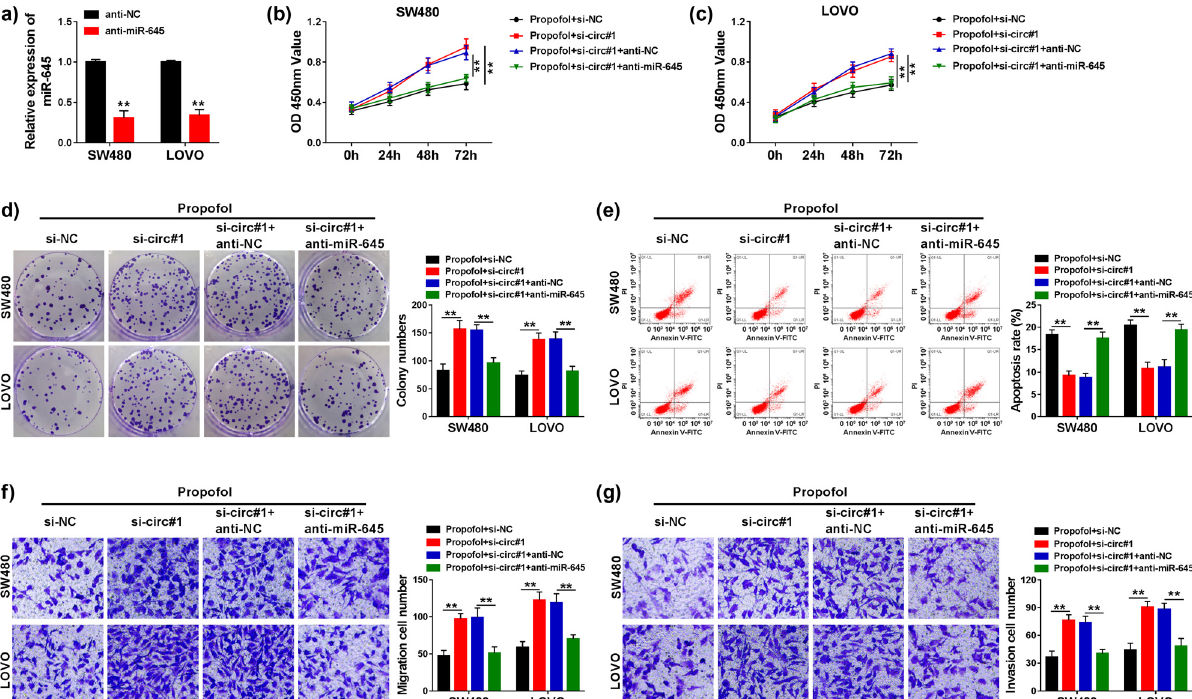
Figure 5: circ_0026344 regulated CRC development by binding to miR - 645 in propofol - treated SW480 and LOVO cells. ( a ) miR - 645 expression was detected by qPCR in SW480 and LOVO cells transfected with anti - NC or anti - miR - 645. SW480 and LOVO cells were treated with propofol + si - NC, propofol + si - circ#1, propofol + si - circ#1 + anti - NC, and propofol + si - circ#1 + anti - miR - 645, respectively. ( b – d ) Cell proliferation was determined by CCK8 and colony formation assays. ( e ) Cell apoptosis was detected by fl ow cytometry assay. ( f and g ) Cell migration and invasion were detected by transwell assay. Signi fi cant di ff erences were compared with Student ’ s t - test ( a ) or ANOVA ( b – g ) . ** P <